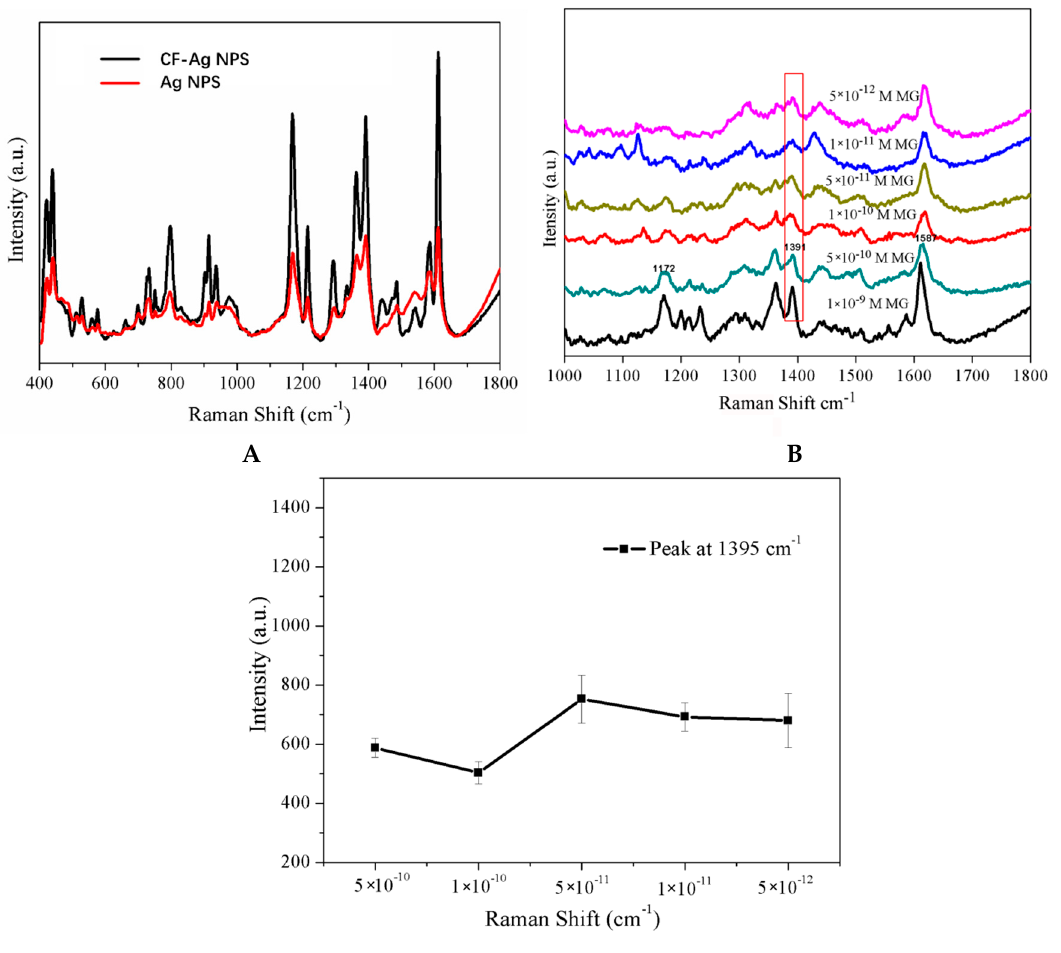
Figure 4. ( A ) SERS spectra of 10 − 8 M MG detected with two sample preparation methods. ( B ) SERS spectra of MG exhibiting a LOD of 10 − 12 M with absorption-method. ( C ) Peak at 1391 cm − 1 in the SERS spectra shown in B.